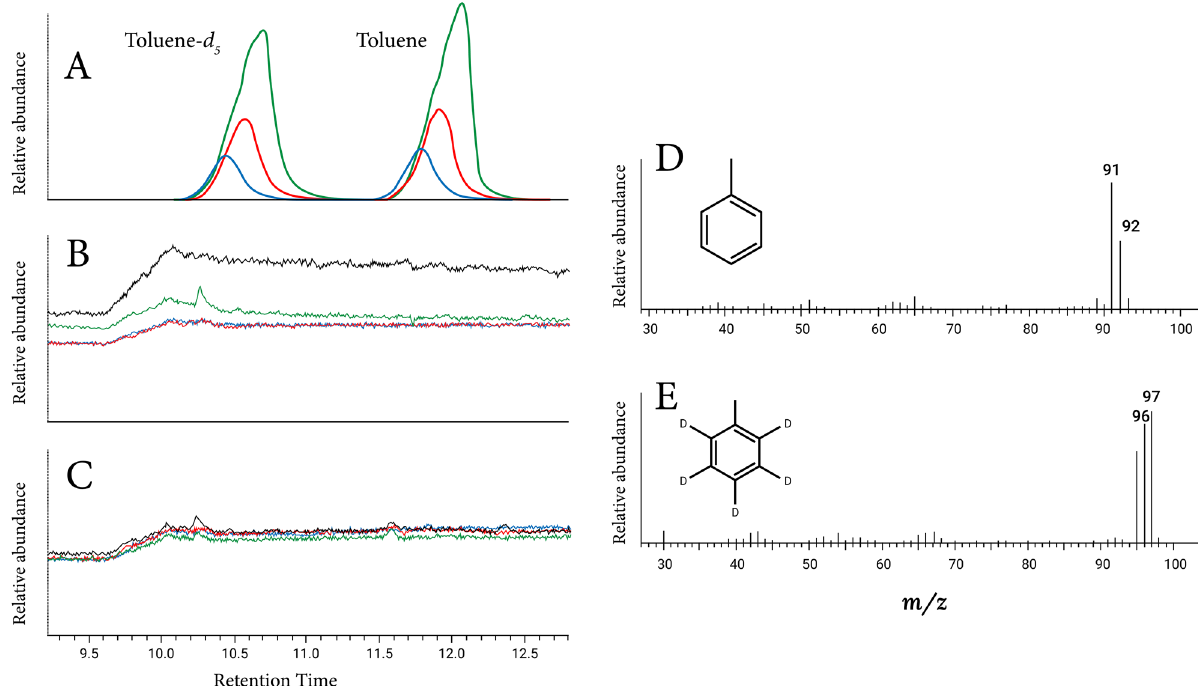
Figure 2. ( A ) Overlaid gas chromatograms showing retention times of toluene and toluene- d 5 in incubations anoxic-1 (green line), anoxic-2 (red line), and anoxic-3 (blue line). ( B and C ) Overlaid chromatograms from control incubations of synthetic seawater (black line) and treatments without inocula (green, red and blue lines, as in caption A) amended with phenylalanine ( B ) and phenyl- d 5 - alanine ( C ). ( D ) Mass spectrum of toluene (retention time 11.9 min) detected in both environmental samples and in anoxic incubations with phenylalanine as substrate. ( E ) Mass spectrum of deuterated toluene (retention time 10.2 min) produced in anoxic incubations with l-phenyl- d